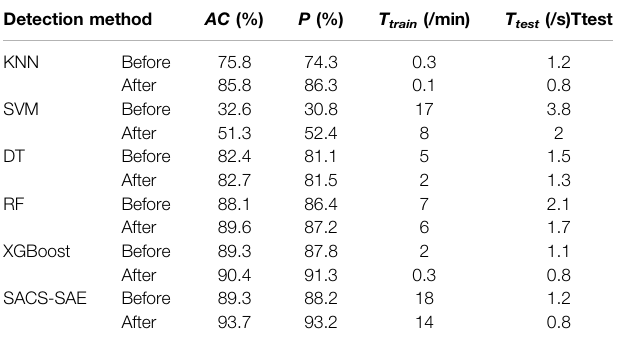
TABLE 3 | Comparison of performance with different models. Detection